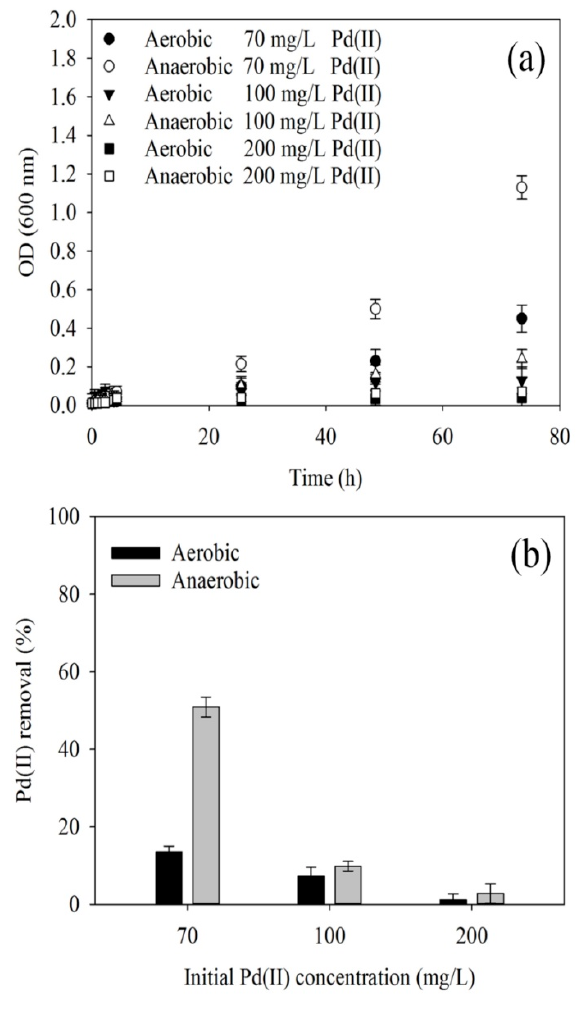
Figure 1. ( a ) Microbial growth curve of microbes from Brits sand drying bed sludge exposed to different initial palladium (Pd)(II) concentrations under aerobic and anaerobic conditions; ( b ) effect of initial Pd(II) on Pd(II) removal under aerobic and anaerobic after 74 h.